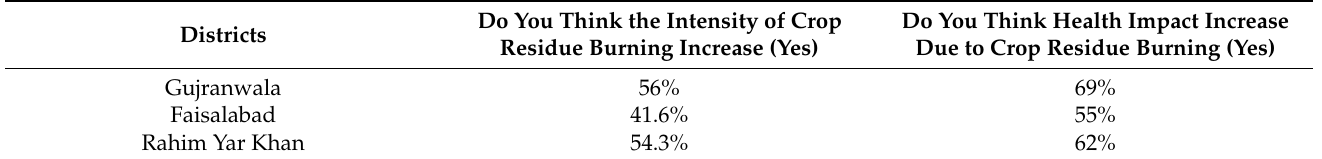
Table 3. Relating the intensity of crop residue burning with the intensity of suffering (percentage response of respondents’ perceptions).